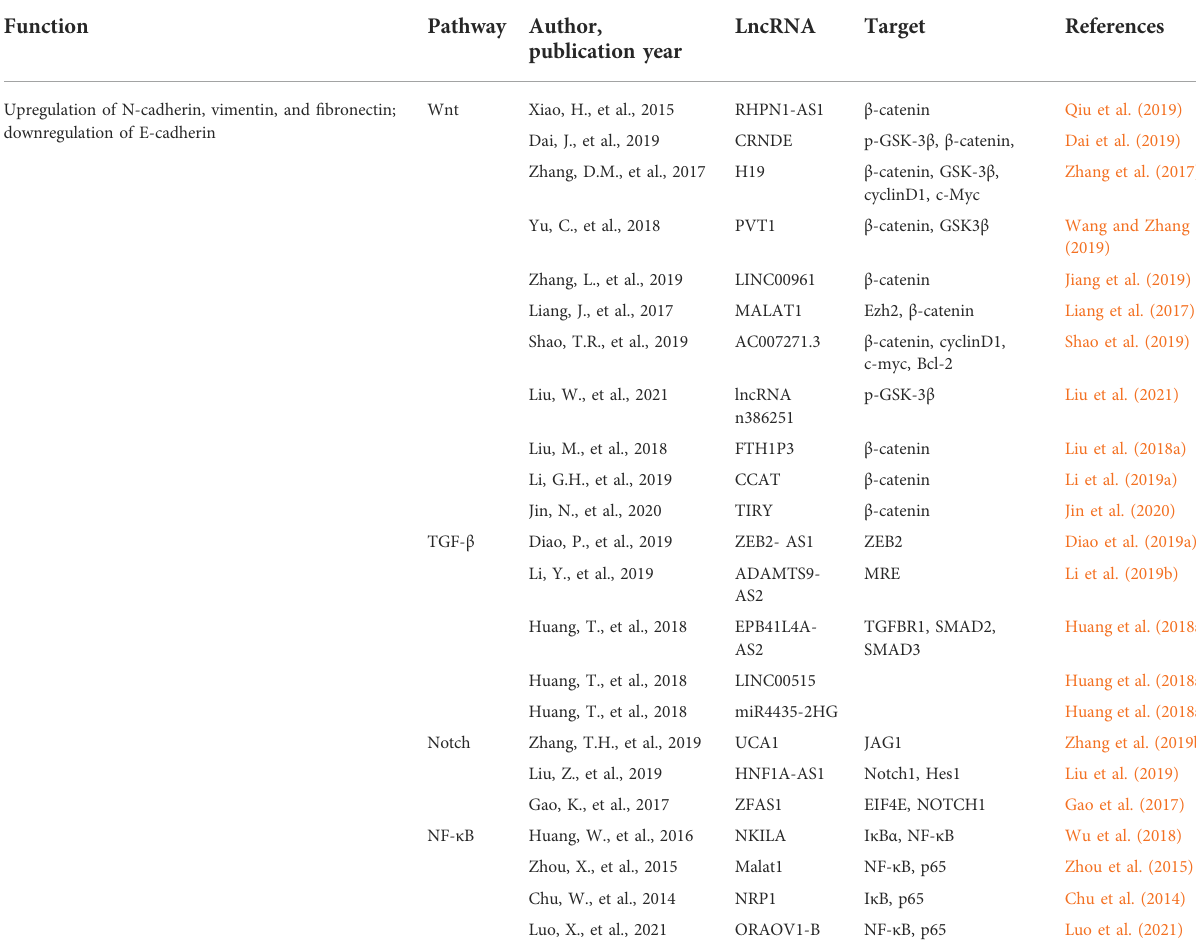
TABLE 1 LncRNAs promote OSCC development via multiple regulatory signaling